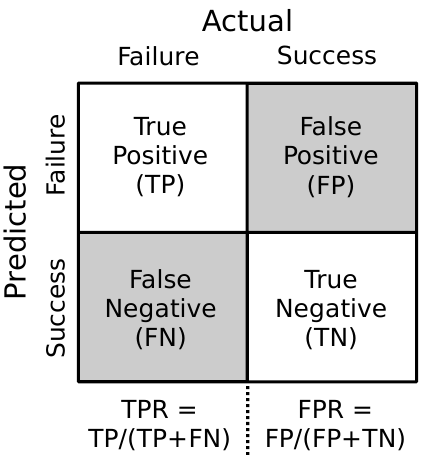
Fig. 5. The confusion matrix showing the four possible outcomes for a two-class simulation failure problem.